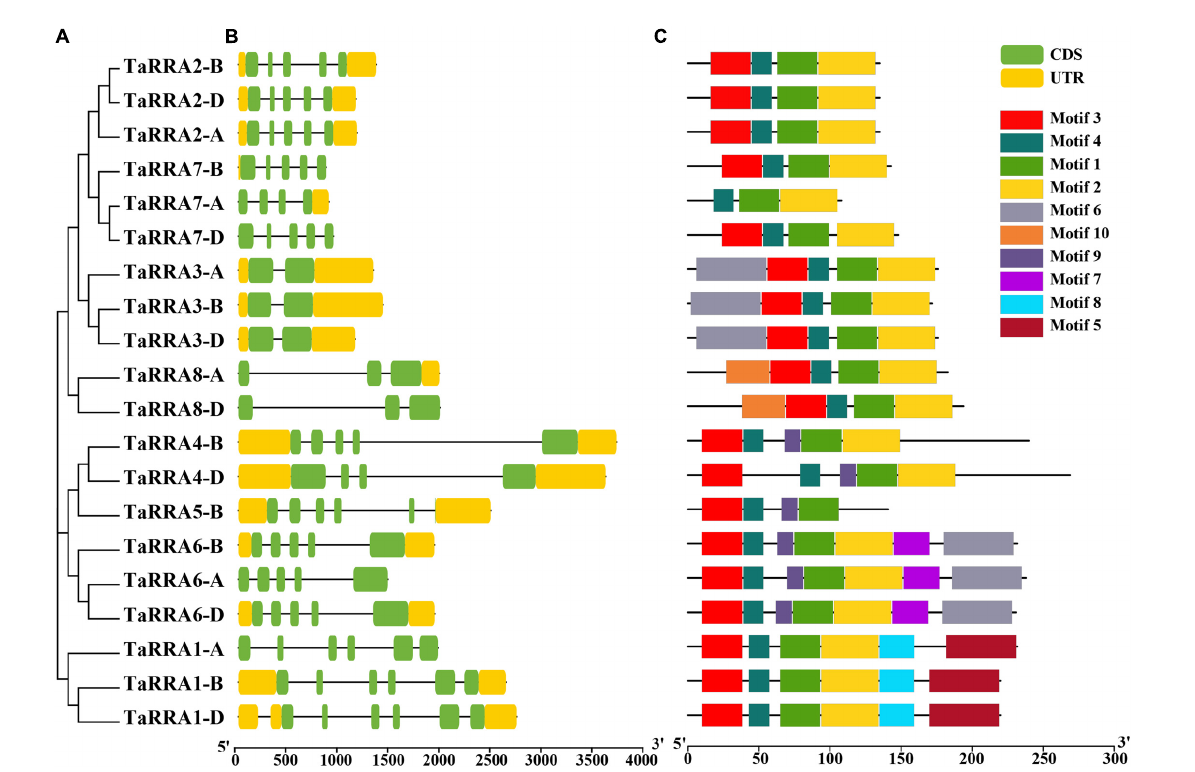
FIGURE2 Phylogenetic analysis, gene structure, and conserved motifs of TaRRAs. (A) The phylogenetic tree was constructed based on the full-length amino acid sequence of TaRRAs. (B) Gene structure analysis of TaRRA genes. Yellow boxes represent UTR regions; green boxes indicate exons; black lines represent introns. (C) Conserved domain structures identified in the TaRRAs. Different color boxes show different